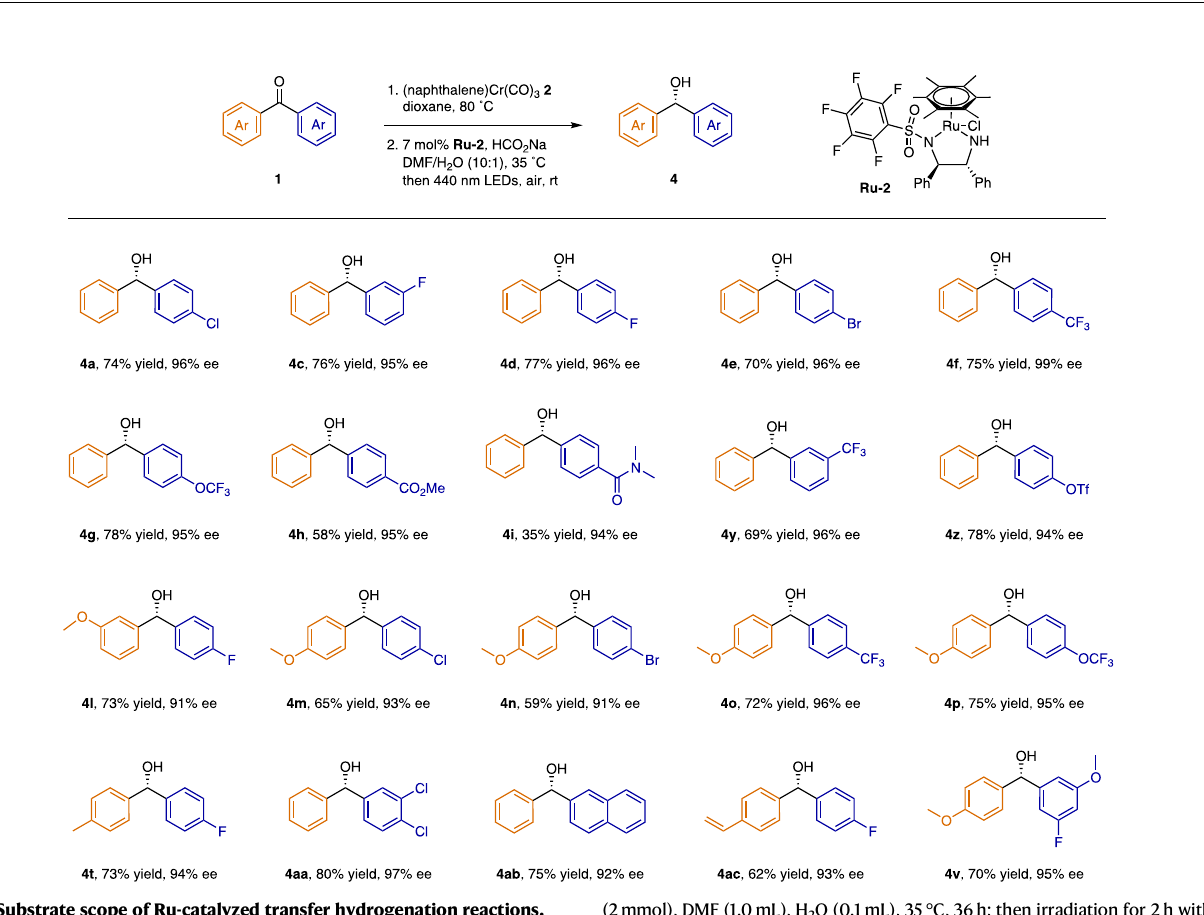
(2mmol), DMF (1.0mL), H 2 O (0.1mL), 35°C, 36h; then irradiation for 2h with 440nm LEDs. Isolated yieldswerereported. The absolute con fi gurationsof 4a , 4e , 4h and 4m were S , as determined by comparing their optical rotations with reported